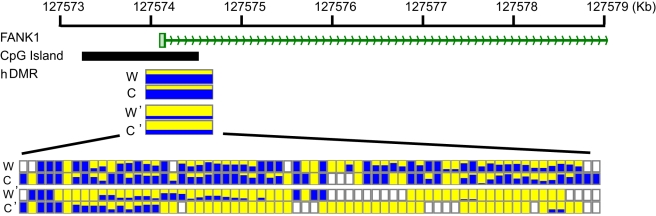
Example of a gene (FANK1) newly identified to display allele-specific methylation (ASM).Tracks 1 and 2 show the position of exon 1 and the associated CpG island, respectively. Track 3 shows the position of the identified haploid differentially methylated region (hDMR), W and C denote the forward (Watson) and reverse (Crick) strands of allele 1, and W' and C' denote the corresponding strands of allele 2. The DNA methylation status is color-coded: hypomethylated (yellow) and hypermethylated (blue). The bottom track shows the underlying bisulfite sequencing data for each CpG in the hDMR. The color code is as above, except for unfilled boxes, which denote the absence of data. The actual methylation level (shown as yellow:blue ratio) was derived from an average of 14.7 reads per CpG site.